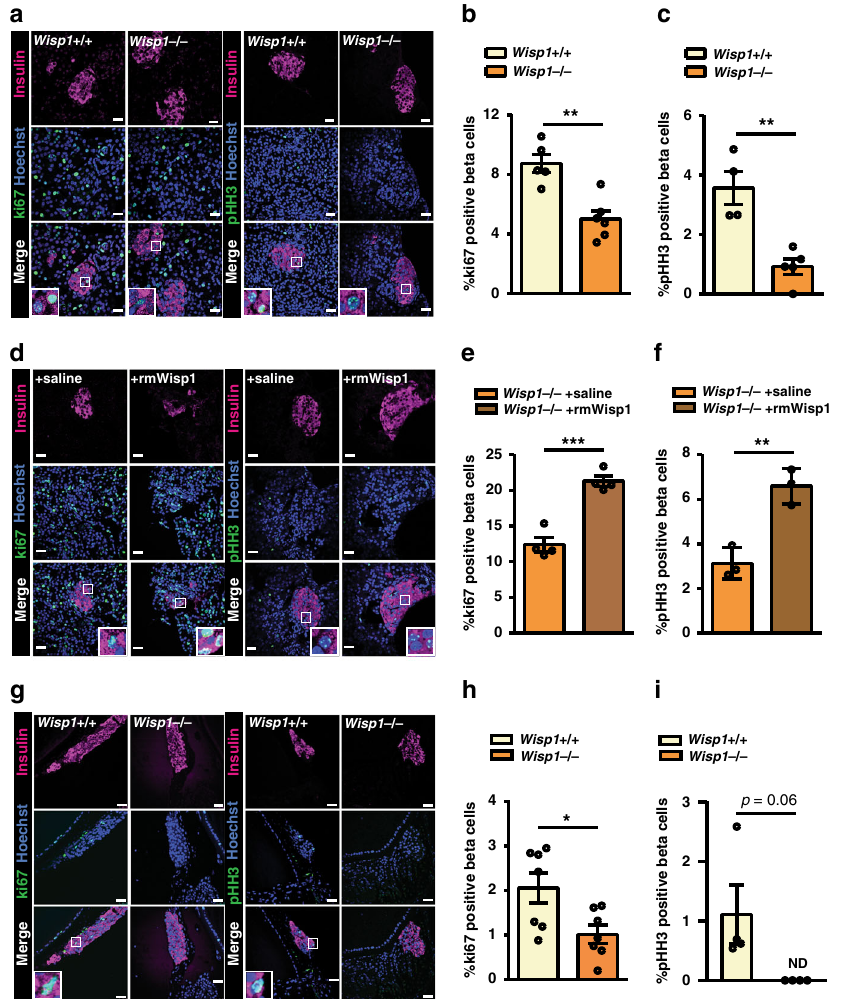
Fig. 3 Wisp1 contributes to beta cell replication in young mice. a – c Beta cell proliferation in fi xed pancreases from p14 Wisp1 + / + or Wisp1 − / − mice. a Representative images of pancreases co-immunostained for insulin (purple)/ki67 (green) or insulin (purple) /pHH3 (green). Nuclei are marked with Hoechst in blue. b Quanti fi cation of the percentage of beta (insulin + ) cells that are ki67 + in Wisp1 + / + ( n = 5, yellow) or Wisp1 − / − ( n = 6, orange) mice. c Quanti fi cation of the percentage of beta (insulin + ) cells that are pHH3 + in Wisp1 + / + ( n = 4, yellow) or Wisp1 − / − ( n = 5, orange) mice. d – f Beta cell proliferation in fi xed pancreases from p12 Wisp1 − / − mice treated with saline or with rmWisp1 protein for three days (from p9 to p11). d Representative images of pancreases co-immunostained for insulin (purple)/ki67 (green) or insulin (purple)/pHH3 (green). Nuclei are marked with Hoechst in blue. e Quanti fi cation of the percentage of beta (insulin + ) cells that are ki67 + in mice injected with rmWisp1 ( n = 4, orange) o saline ( n = 4, brown). f Quanti fi cation of the percentage of beta (insulin + ) cells that are pHH3 + in mice injected with rmWisp1 ( n = 3, orange) o saline ( n = 3, brown). g – i Beta cell proliferation of 20wo mouse islet grafts transplanted into the anterior chamber of the eye of p16 Wisp1 + / + or Wisp1 − / − mouse recipients. g Representative images of islet grafts co-immunostained for insulin (purple)/ki67 (green) or insulin (purple)/pHH3 (green). Nuclei are marked with Hoechst in blue. h Quanti fi cation of the percentage of beta (insulin + ) cells that are ki67 + in p16 Wisp1 + / + ( n = 7, yellow) or Wisp1 − / − ( n = 7, orange) mice. i Quanti fi cation of the percentage of beta (insulin + ) cells that are pHH3 + in p16 Wisp1 + / + ( n = 4, yellow) or Wisp1 − / − ( n = 4, orange) mice. All data values represent mean ± SEM for the indicated n . * p < 0.05; ** p < 0.01 using two-tailed Student ’ s t test. Scale bars are 25 μ m. ND: not